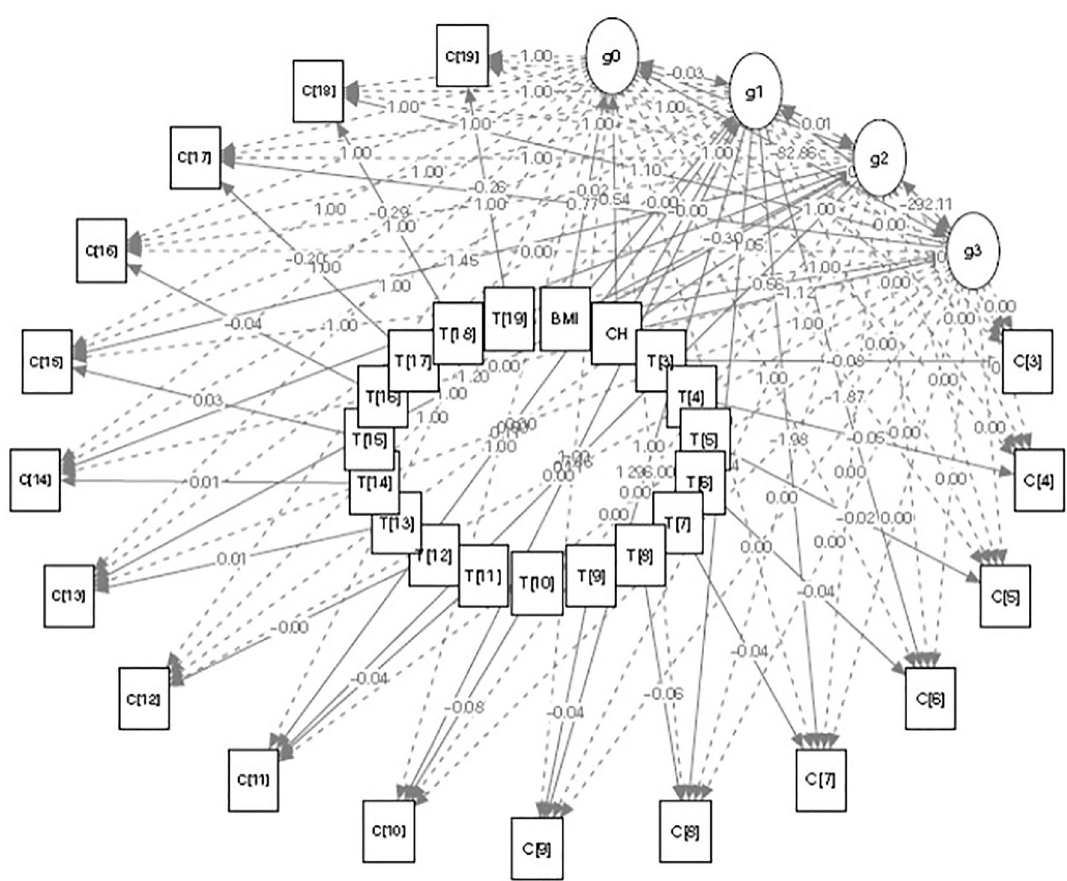
Figure 4. Structure plot for model 8 (multiphase model with temperature + BMI + cholesterol as covariates). Here, C represents the outcome variable; T represents the monthly average environmental temperature (MAET); CH represents cholesterol; g 0 , g 1 , g 2 and g 3 represents the latent variables. The dotted lines show the fixed coefficients and the bold lines show the estimated coefficients.